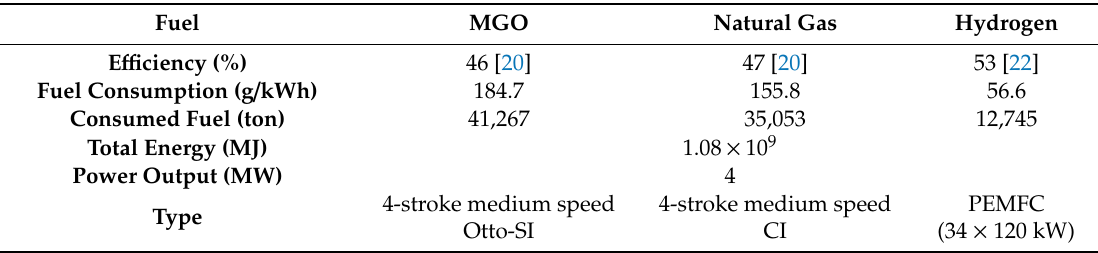
Table 5. Engine and fuel cell with motor specifications in the Tank-to-Wake